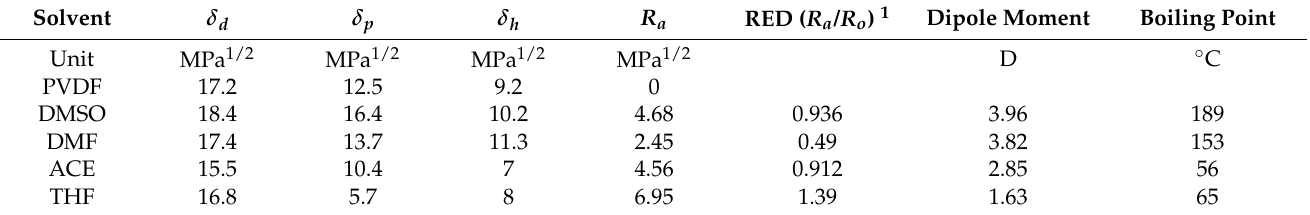
Table 1. The Hansen solubility parameters and physical properties of PVDF and various